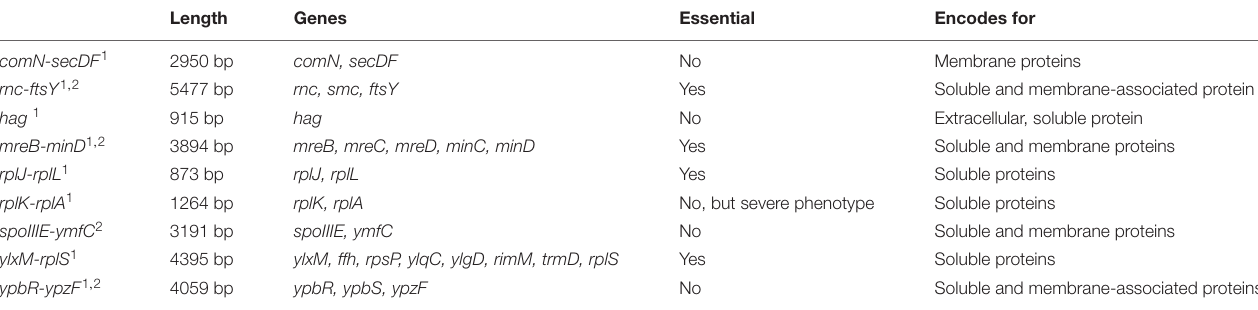
TABLE 1 | List of mRNAs analyzed in this study and their encoded